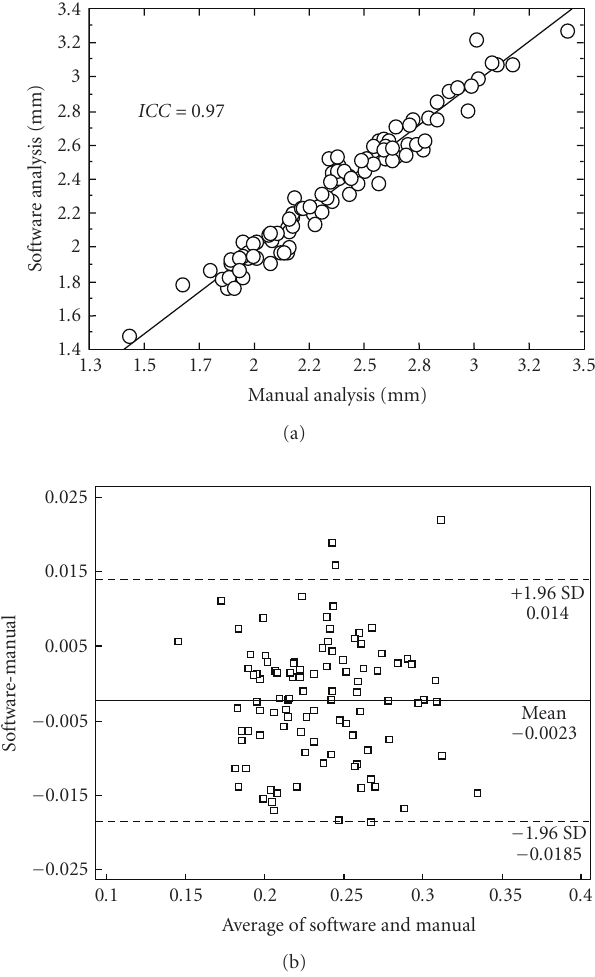
Figure 5: FMD analysis. (a) Correlation between manual (gold standard, horizontal axis) and automatic (vertical axis) analyses; (b) Bland and Altman plot: di ff erence between software and manual measurements versus their